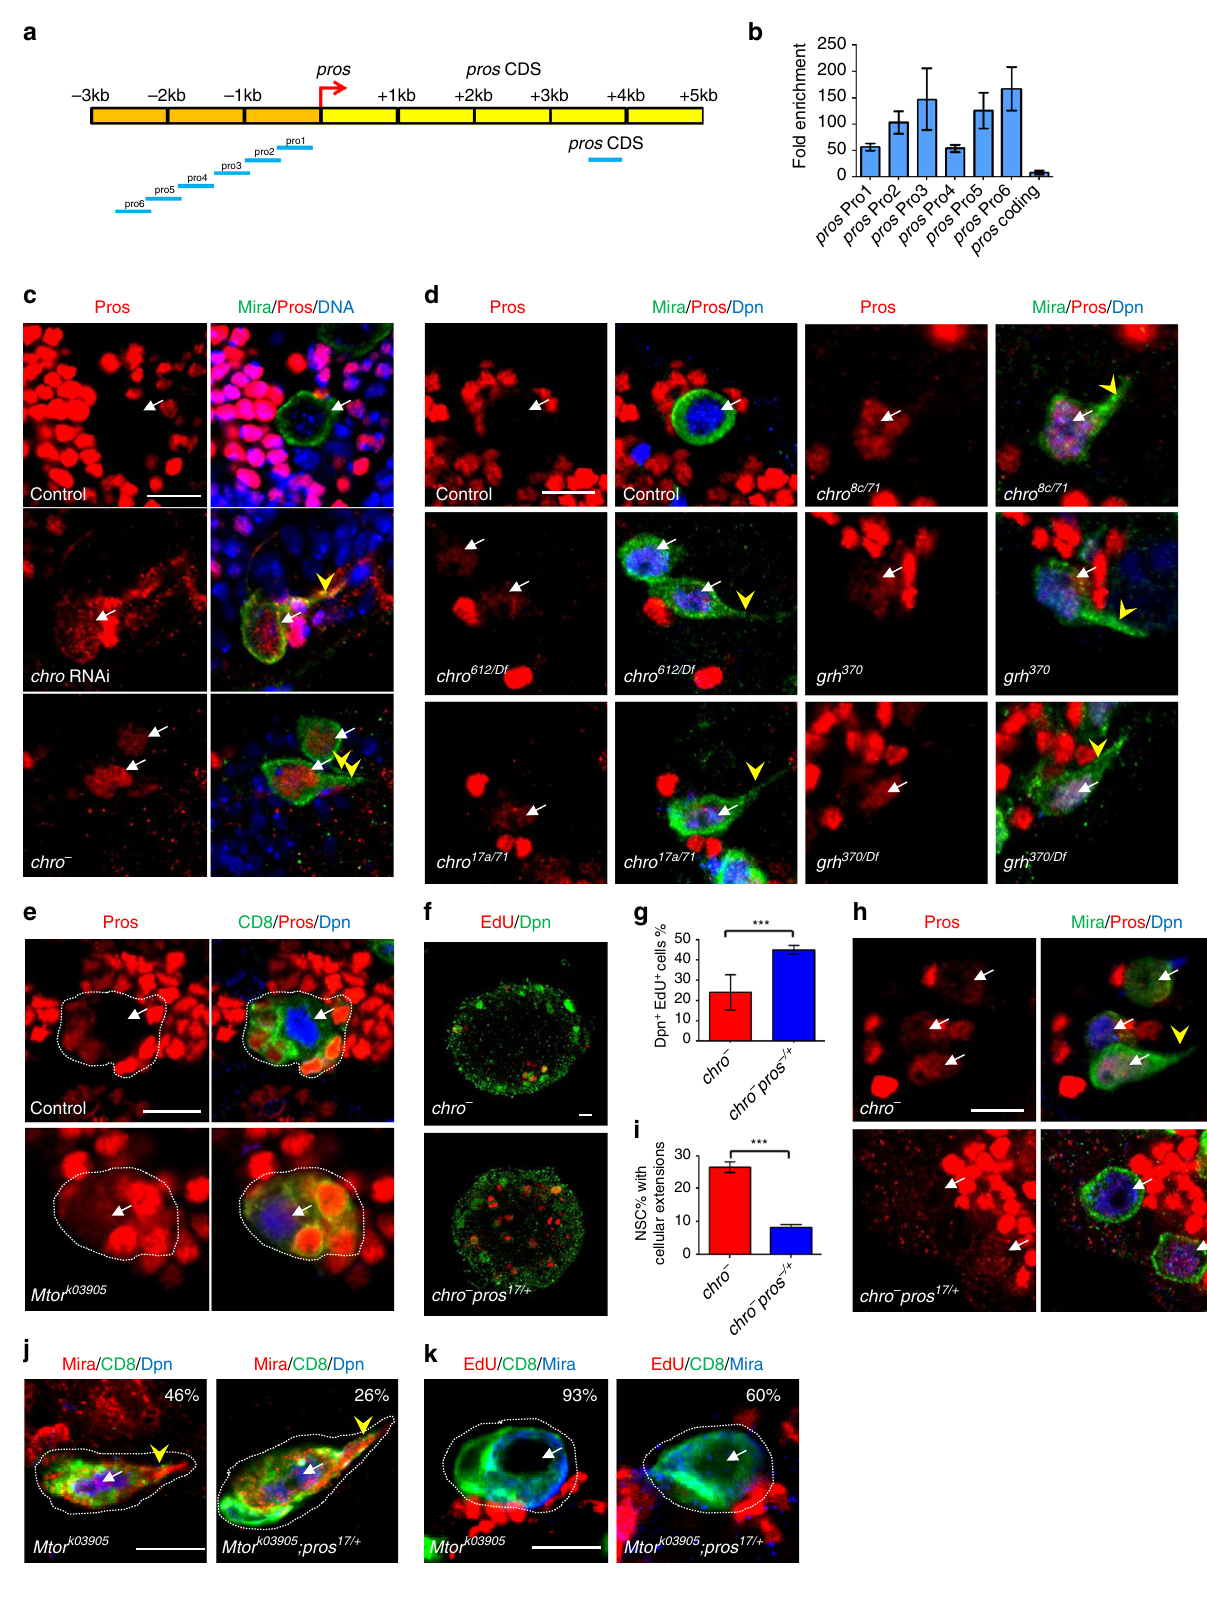
In vivo pro fi ling of Chro identi fi ed Grh as a target in NSCs . To identify the targets of Chro in NSCs, we carried out targeted DNA adenine methyltransferase (Dam) identi fi cation